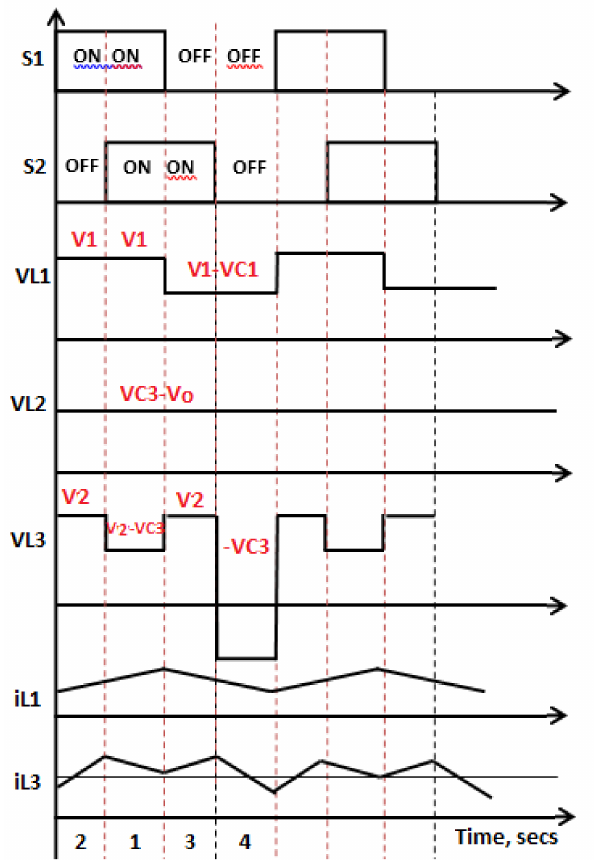
Figure 4. Various functional